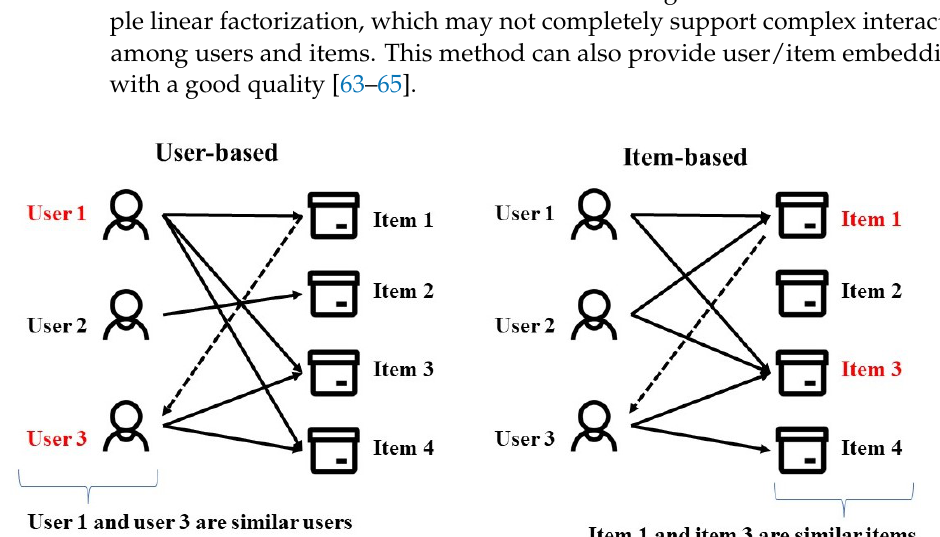
Figure 10. The Differences between user-based and item-based